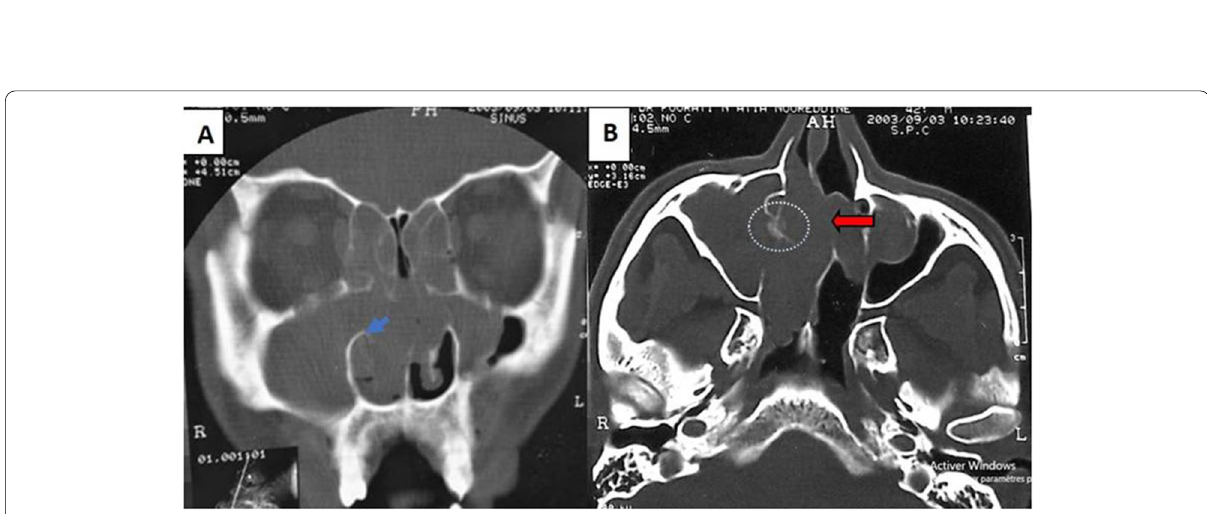
image in the LNW (circle) and nasal septum bowing (red arrow) on the right side: Right IP associated with